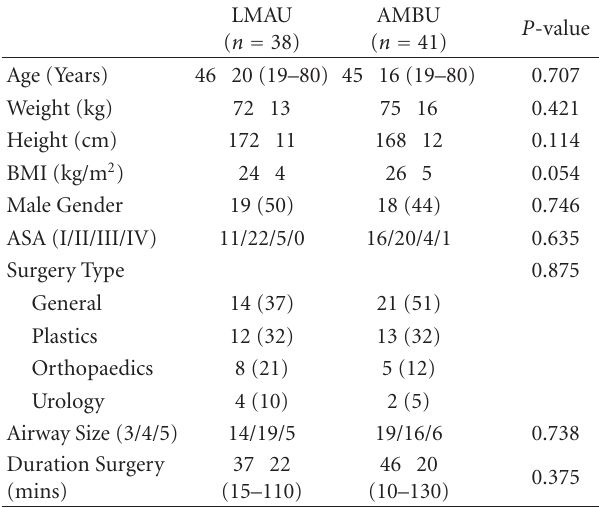
Table 1: Patient demographics, surgery type, and airway